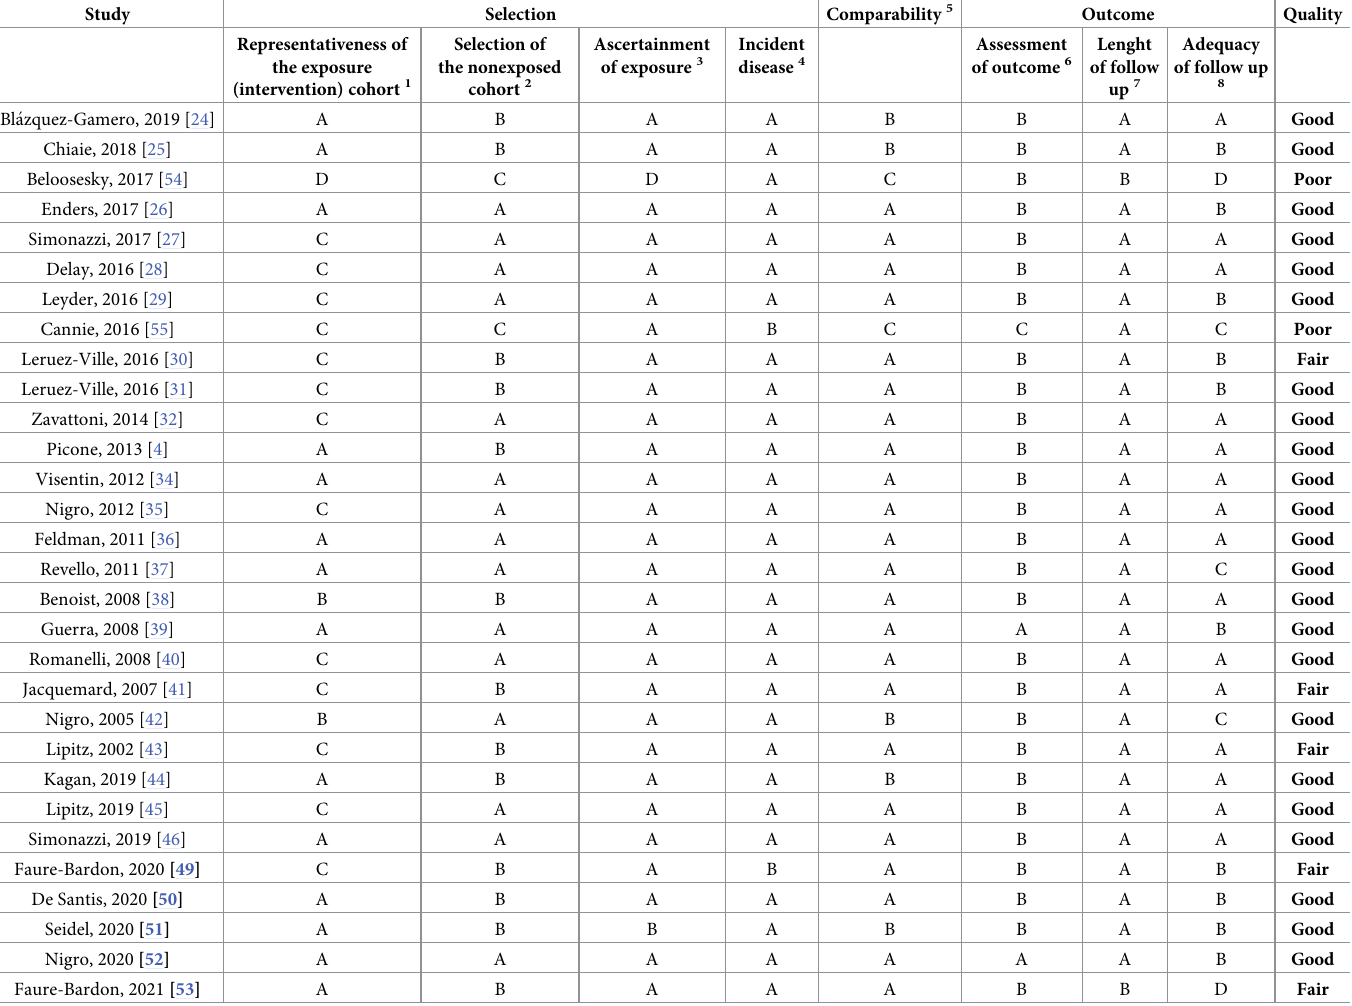
Table 2. Evaluation of risk of bias for observational studies (NOS